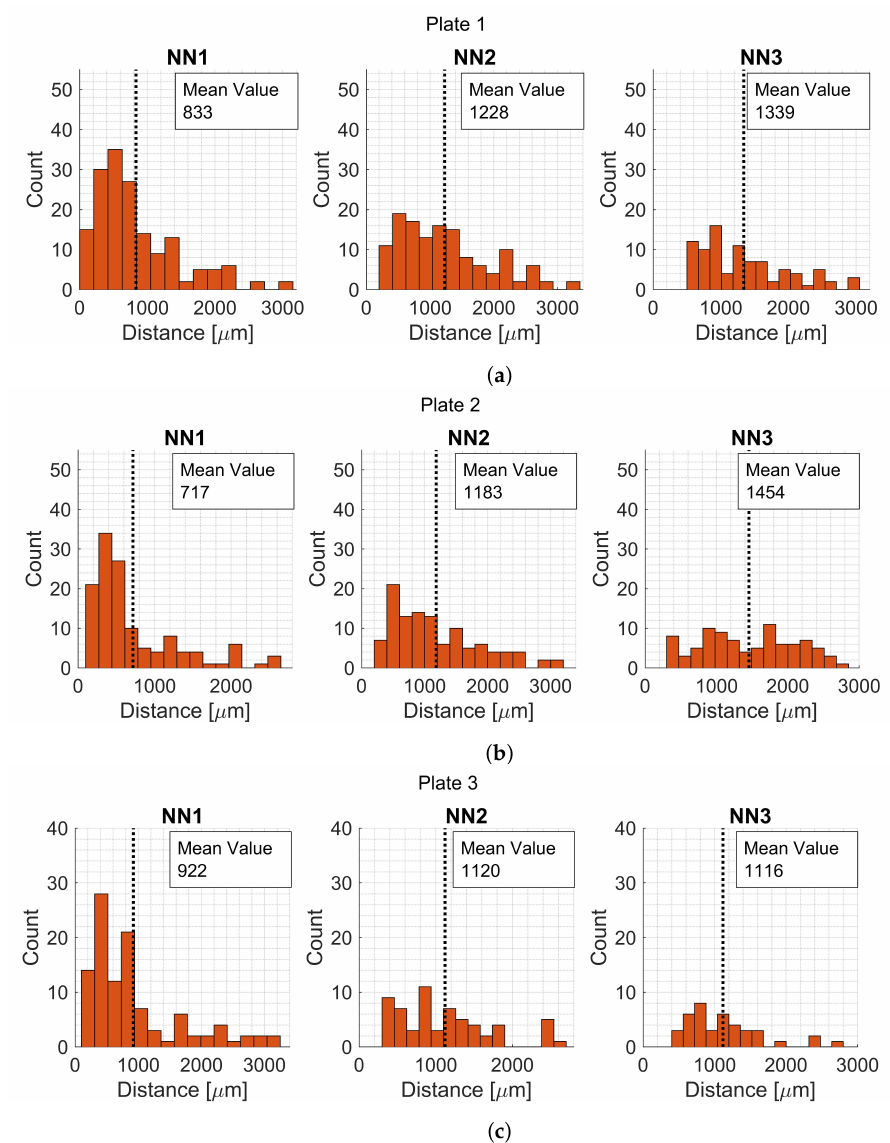
Figure 14. Histograms for first, second and third NN for ( a ) Plate 1, ( b ) Plate 2, and ( c ) Plate 3. Not only void fraction could affect a material behavior, but also the different void data parameters that were extracted. The void data parameters were compared using ANOVA and the analyses are summarized in Table 19 with their respective null hypothesis and